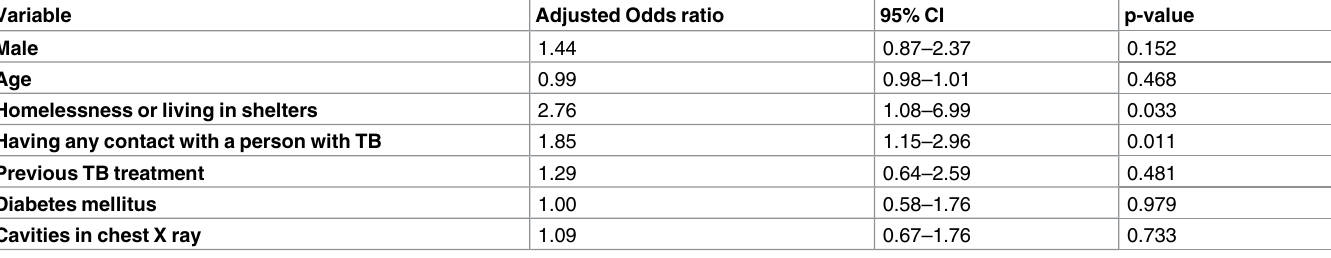
Table 3. Variables Associated to IMR by Multivariate